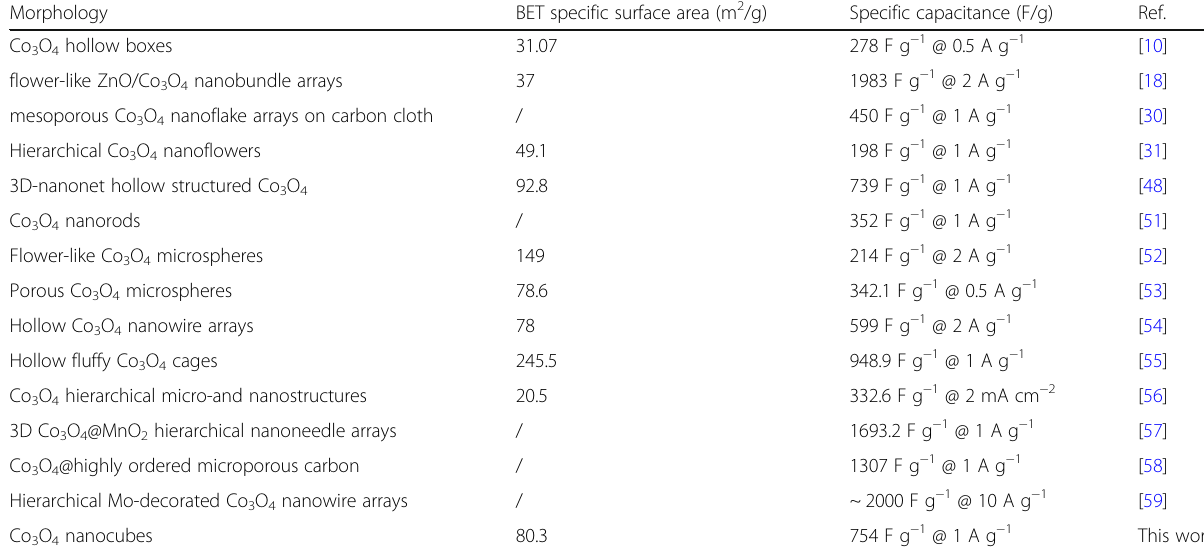
Table 1 Comparison for the specific capacitances of Co 3 O 4 -based electrode materials Morphology